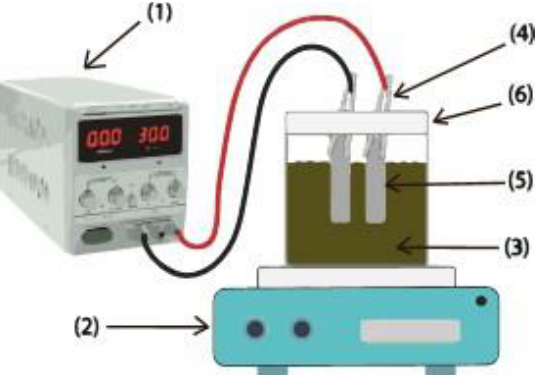
Figure 1. Schematic representation of the experimental set-up for electrocoagulation: 1 — direct current power source, 2 — magnetic stirrer, 3 — piggery wastewater, 4 — electrical wires and alligator clips, 5 — electrode plates, and 6 — stabilizing cap.